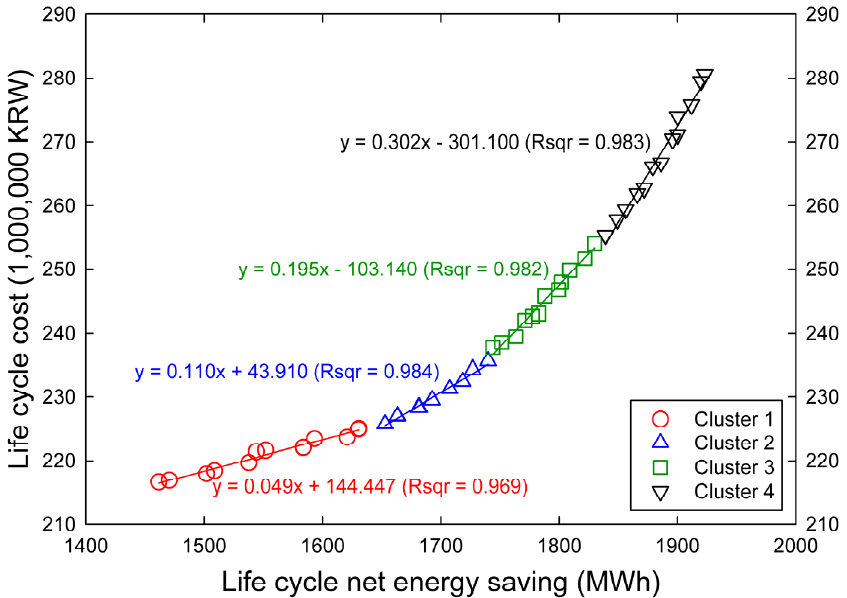
Figure 6. Pareto frontier for last generation in case study.